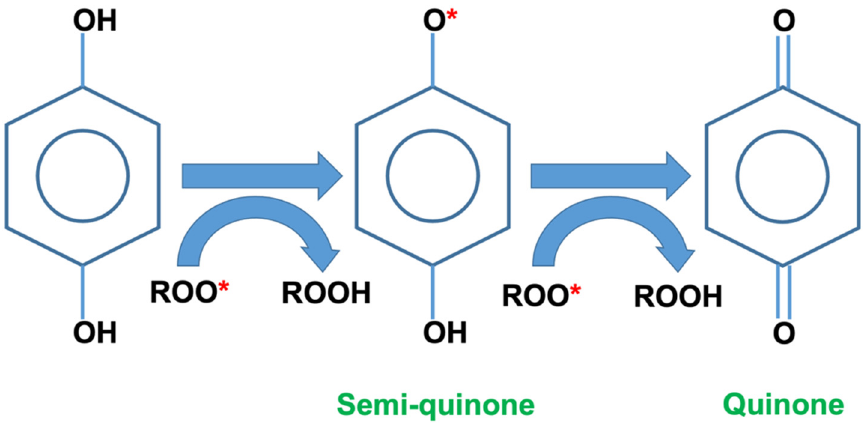
Figure 6. Schematic illustration of the anti-degradant function of phenolic-contained lignin (* is the radical).